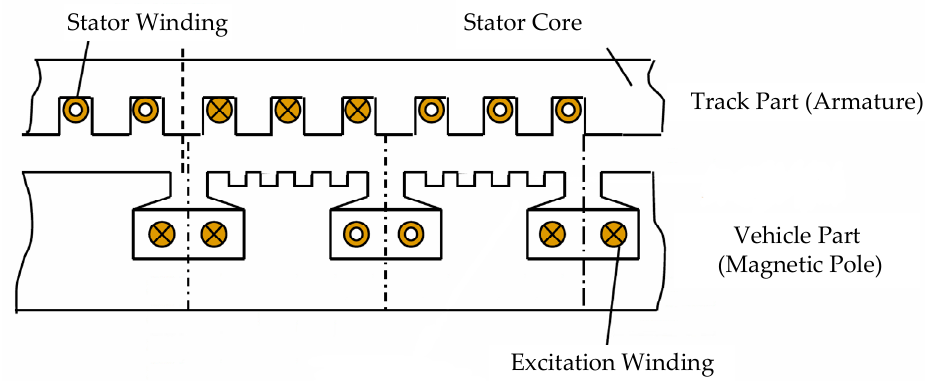
Figure 3. LLSM lateral profile.